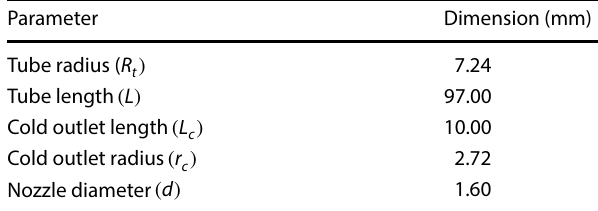
Table 2 Dimensions of the vortex tube